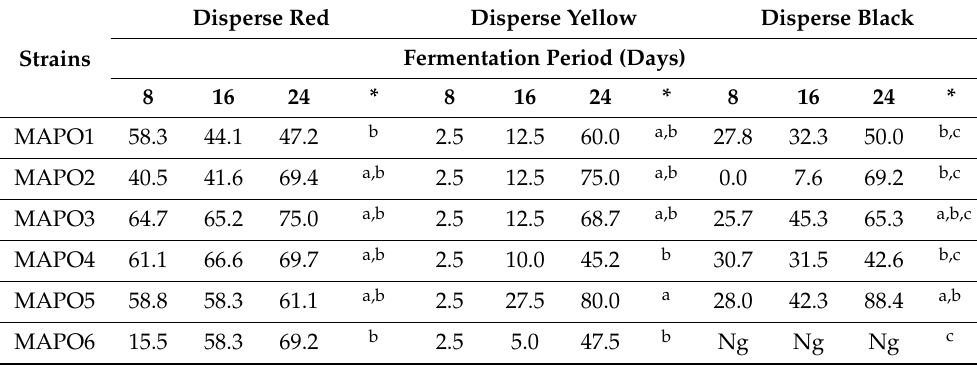
Table 4. Percentage of disperse-dye decolorization with isolated fungi cultured in a shake flask with carbon-limited medium containing 150 mg L − 1 dye. Disperse Red Disperse Yellow Disperse Black Strains